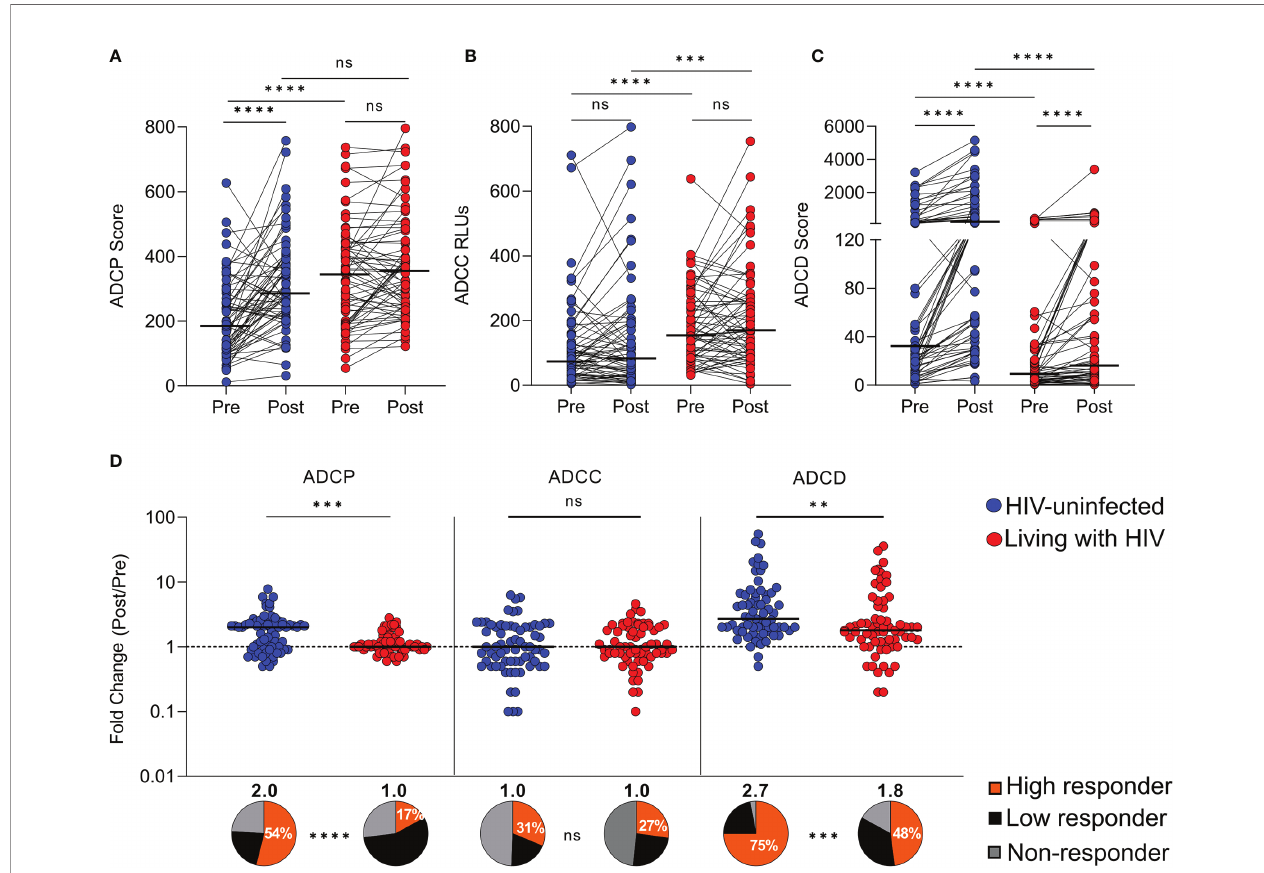
FIGURE 2 | Differential boosting of HA stalk-speci fi c Fc-mediated antibody functions amongst vaccinated women. Pre-vaccination and 1-month post-vaccination H1 stalk-speci fi c (A) antibody-dependent cellular phagocytosis (ADCP), (B) antibody-dependent cellular cytotoxicity (ADCC) or Fc g RIIIa activation and (C) antibody- dependent complement deposition (ADCD) are shown where HIV-uninfected participants (n=67), shown in blue and participants living with HIV (n=66), shown in red. (D) The fold increases for each of the functions and the proportion (%) of high responders that exceed a 2-fold increase in Fc activity are shown in orange. Low responders, who show reduced enhancement that does not reach a 2-fold increase are shown in black, whilst those not boosted (non-responders) are shown in grey. The lines represent the median. Wilcoxon matched-pairs signed rank tests were used to compare pre-vaccination and post-vaccination functional scores within groups. Mann Whitney U test was used to compare functional scores between the vaccine groups. Fischer ’ s exact tests were used to compare the proportions of high responders. Signi fi cant associations are shown as ****p < 0.0001; ***p < 0.001; **p < 0.01; ns,not signi fi